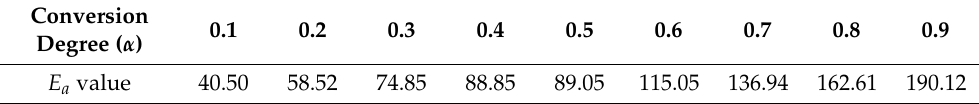
Figure 11. KAS plot of Fe 2 O 3 /charcoal composites at different weight loss stages. Table 5. Apparent activation energy values computed at overall reduction